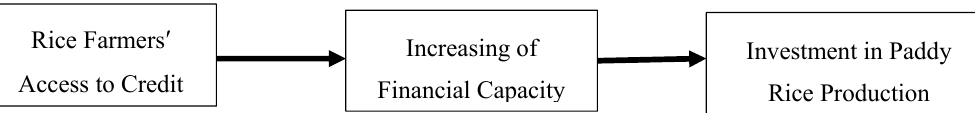
Figure 1. Theoretical framework.